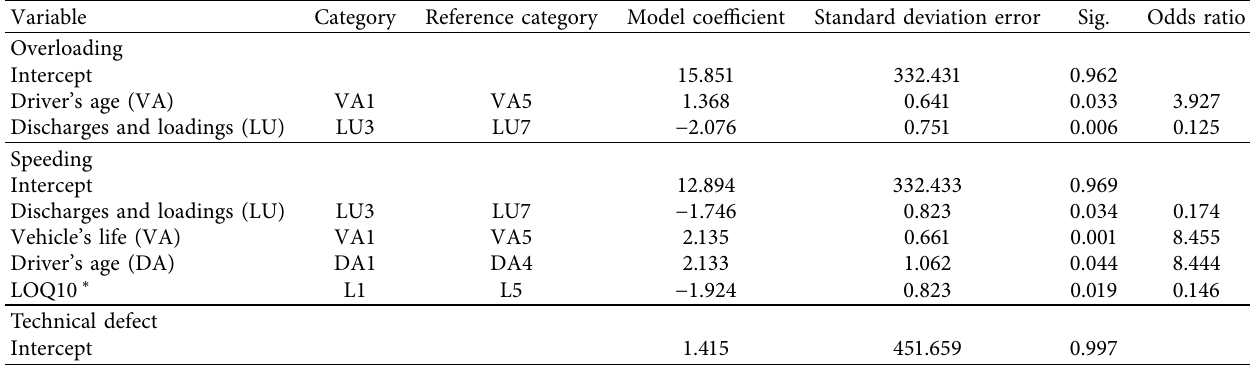
Table 5: Results of multivariate regression statistical model